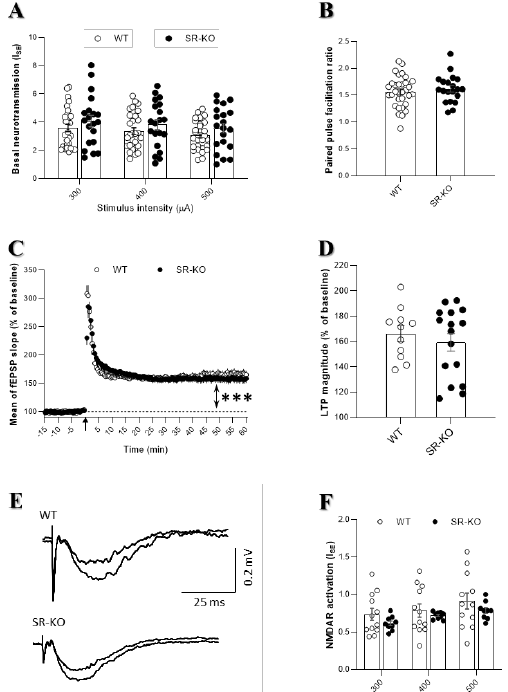
Figure 3. SR deletion does not change the functional output of CA1 hippocampal networks. ( A ). Index of synaptic efficacy (I SE ) corresponding to the fEPSP/PFV slope ratio of AMPA receptor-mediated synaptic responses plotted against current intensity in WT ( n = 28 slices) and SR-KO mice ( n = 20 slices) (using two-way ANOVA). ( B ). Paired-pulse facilitation ratio of synaptic transmission in the WT ( n = 32 slices) and SR-KO ( n = 20 slices) mice (unpaired t-test with Welch’s correction). ( C ). Time-course of long-term potentiation of synaptic transmission induced by a conditioning stimulus of 1 × 100 Hz (black arrow) in WT ( n = 11 slices) and SR-KO ( n = 16 slices) mice. LTP is promoted in both groups, in regard to the last 15 min compared to baseline (*** p < 0.0001 for one sample t-test vs. 100 for each group). ( D ). LTP magnitude during the last 15 min in WT and SR-KO mice (two-way ANOVA repeated measures). ( E ). Superimposed traces of long-lasting N-methyl-D-aspartate (NMDAR)-induced fEPSPs recorded in a slice from a WT (up) and SR-KO mouse (down) at 300 and 400 µ A stimulation intensities. ( F ). I SE of NMDAR-mediated synaptic potentials isolated in WT ( n = 13 slices) and SR-KO ( n = 9 slices) mice (two-way